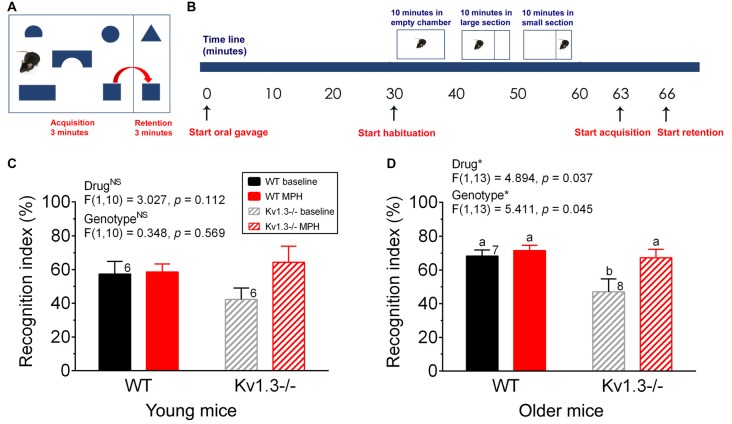
Object-based attentional deficits of male Kv1.3−/− can be ameliorated by MPH treatment. (A) Schematic diagram of the object-based attention test apparatus whereby mice are permitted a 3-min interval in the acquisition chamber followed by a 3-min testing interval in the retention chamber. (B) Schematic time line of the experiment. Preceding habituation, each mouse was orally gavaged (start oral gavage) with saline or MPH and was returned to its home cage for 30 min. After this period, habituation began and occurred in three stages, each 10 min in duration. For the first 10 min, the mouse was free to explore the entire empty apparatus. A removable divider was then placed within the apparatus, dividing the cage into a large acquisition chamber and a small retention chamber. The mouse was free to explore the large acquisition chamber for 10 min, then the small retention chamber for 10 min. After habituation, the mouse was placed in the center of the acquisition chamber that now included the shape objects and was permitted to roam the chamber for 3 min (the acquisition phase). After this time, the removable divider was raised and the mouse was gently guided into the retention chamber. Once the mouse was in the smaller chamber, the divider was slid back into place and the mouse was permitted to roam the retention chamber for 3 min (the retention phase). Bar graph of the recognition index for (C) young vs. (D) older mice. (C,D) young = 2–5 months, older = 8–12 months of age. Same statistical analyses and notations as in Figure 2.